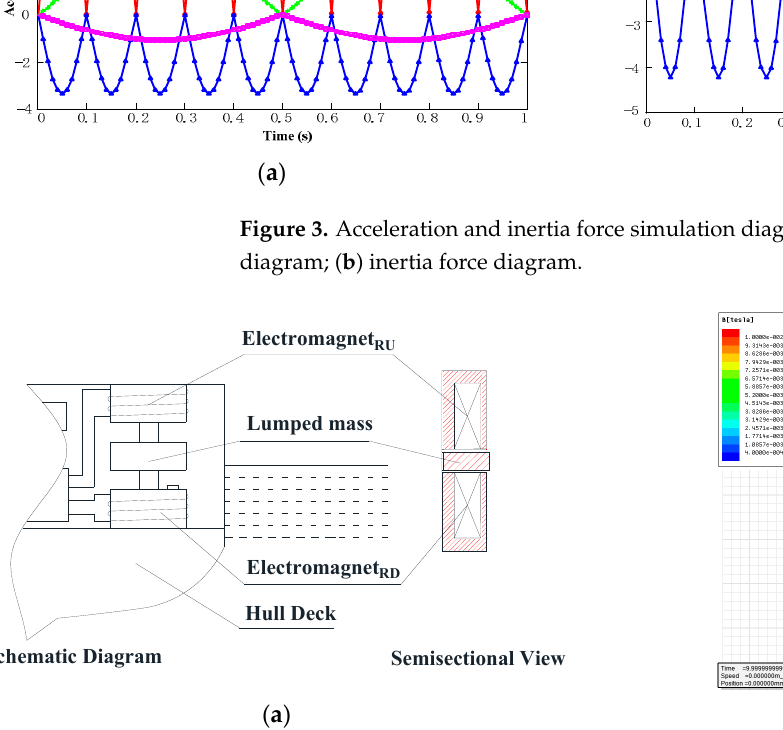
Figure 3. Acceleration and inertia force simulation diagram of mass block and base. ( a ) Accelera- tion diagram; ( b ) inertia force diagram.